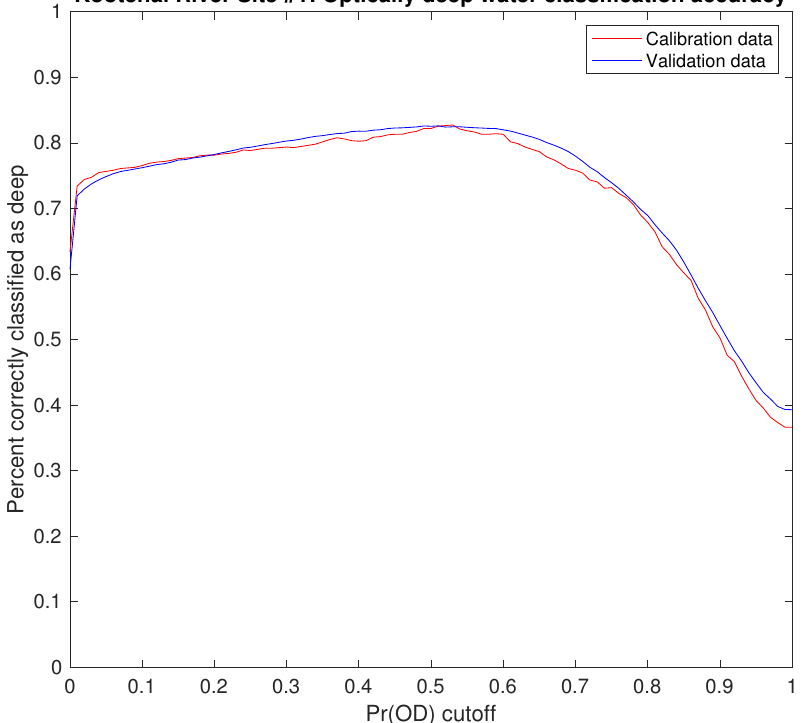
Figure 9. Accuracy of classifying pixels as optically deep as a function of Pr ( OD ) calculated from the logistic regression